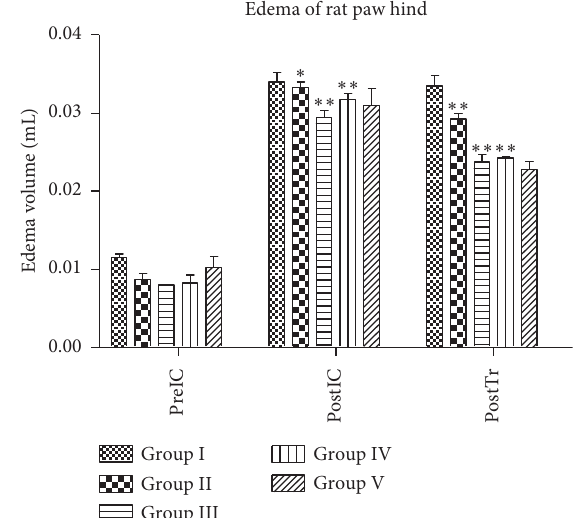
Figure 1: The measurement of palms’ edema volume (Group I � negative control, Group II � EA200, Group III � EA300, Group IV � EA400, and Group V � positive control; PreIC � preinduced carrageenan, PostIC � postinduced carrageenan, and Post- Tr � posttreatment; data are presented as mean ± SEM). ∗ p > 0 . 05 vs. Group I; ∗∗ p < 0 . 05 vs. group I.